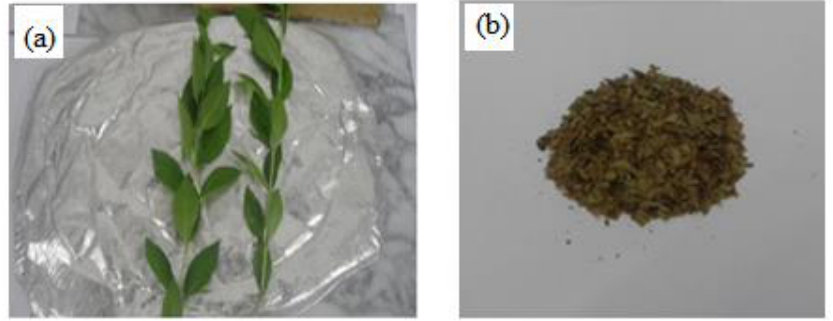
Figure 1. ( a ) Lawsonia inermis fresh leaves; and ( b ) leaves powder.